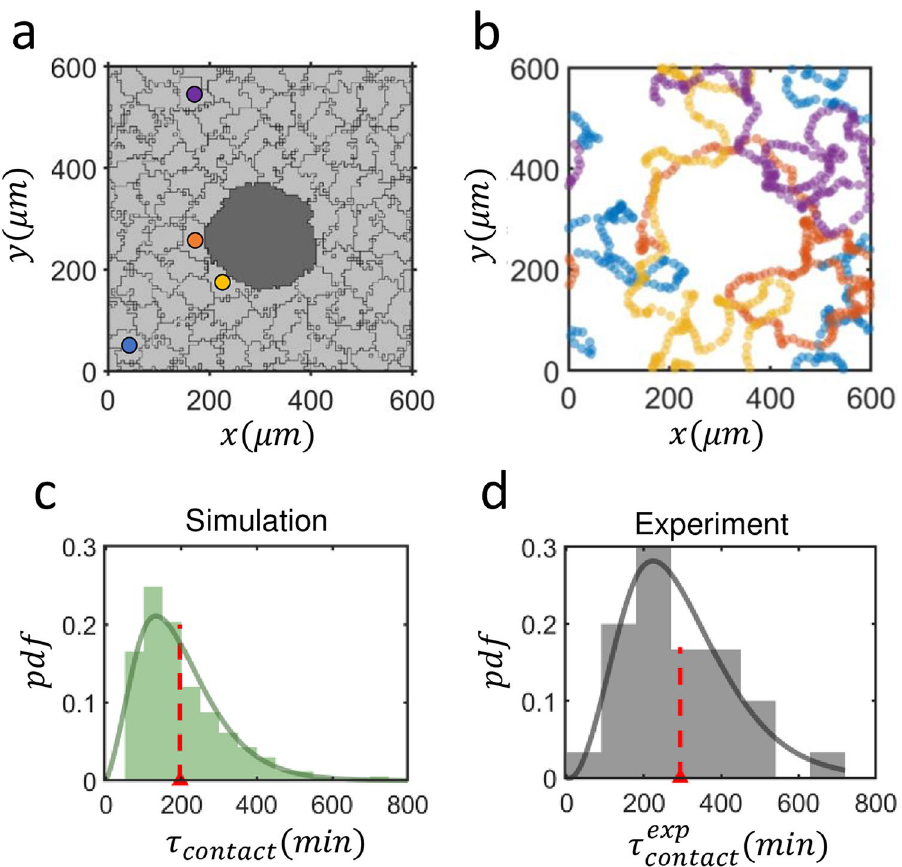
Figure 4. Contact-time statistics of the normal cells to senescent cells within confluent population. ( a ) A snapshot image of a CPM simulation: senescent cell (dark gray) and normal cells (light gray). ( b ) Color- matched trajectories of 4 randomly picked cells marked in ( a ) interacting with the senescent cell. A total of 91 non-senescent normal cells and 1 senescent cell filled space without any voids under a periodic boundary condition. The simulations are conducted with E = − 20 and V target 3.4 × 10 4 μm 2 for 10 4 MCS. ( c ) Histogram = of a population/ensemble-averaged contact duration τ contact (196 ± 122 min, mean ± sd) between normal and senescent cell pairs over 30 different runs with different initial conditions. The solid line draws fitted 3.17, β 62.00 . ( d ) Histogram of the contact duration τ exp gamma function with coefficients α contact ( n = 30, = = 4.22, β 69.75 is shown 294 ± 140 min, mean ± sd) measured in experiments. Fitted gamma function with α = = as dark gray line. The red dashed lines in ( c ) and ( d ) indicate the mean